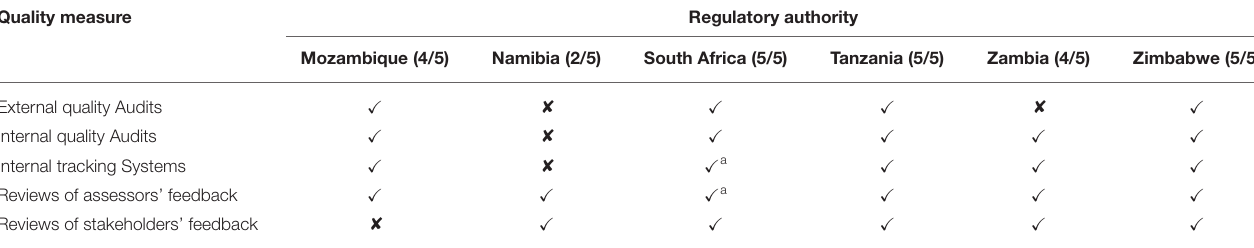
TABLE 5 | Comparison of continuous improvement initiatives in the six regulatory authorities. Quality